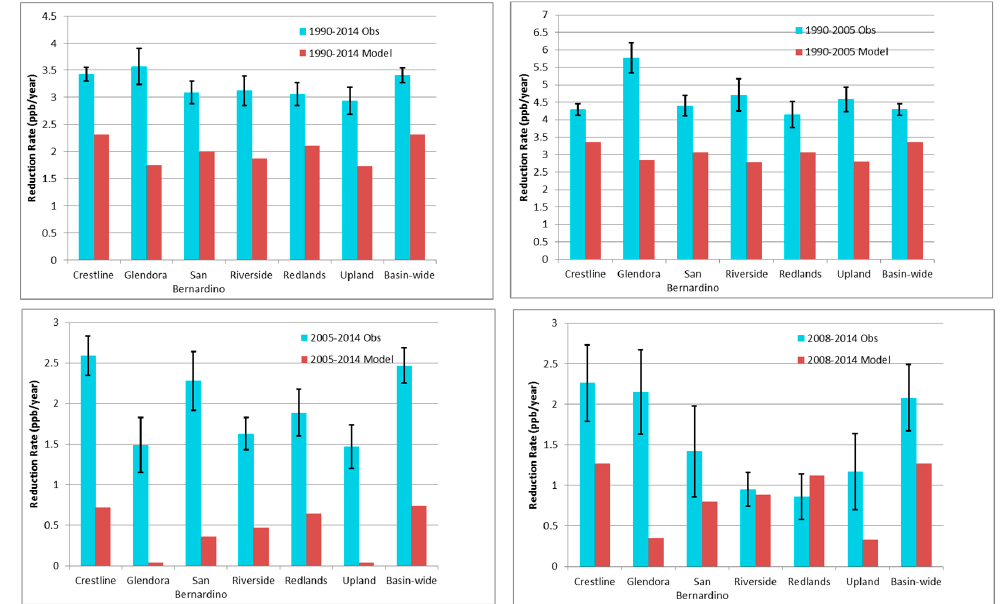
Figure 6. Multi-year modeled and observed reduction rates of 5-year ozone design values at selected monitors using the 2012 AQMP modeling database for the periods from 1990 to 2014 ( top left ), 1990 to 2005 ( top right ), 2005 to 2014 ( bottom left ), and 2008 to 2014 ( bottom right ). The observed rates include error bars to indicate the uncertainty in their calculation.